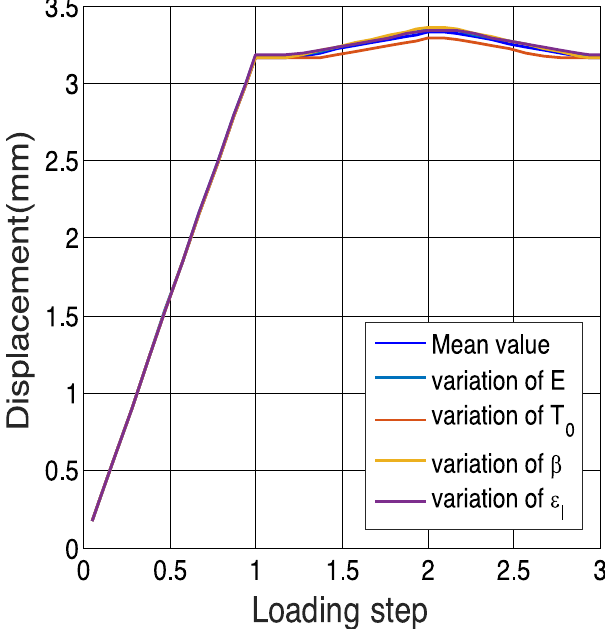
Fig. 7. Variables with in fl uence in the displacement.